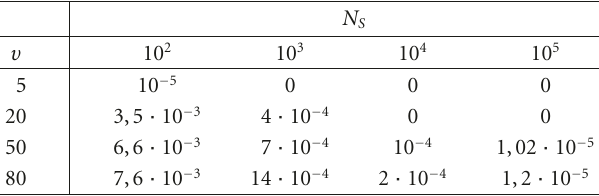
Table 2: ML estimator: mean squared error obtained by simulation. Results obtained considering 10 4 realizations of the ML